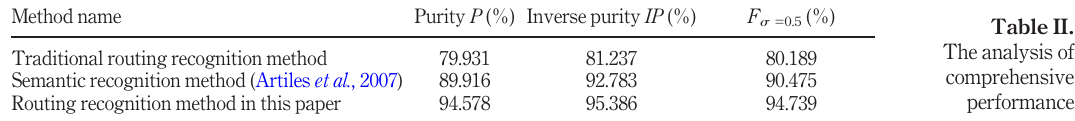
Table II. The analysis of